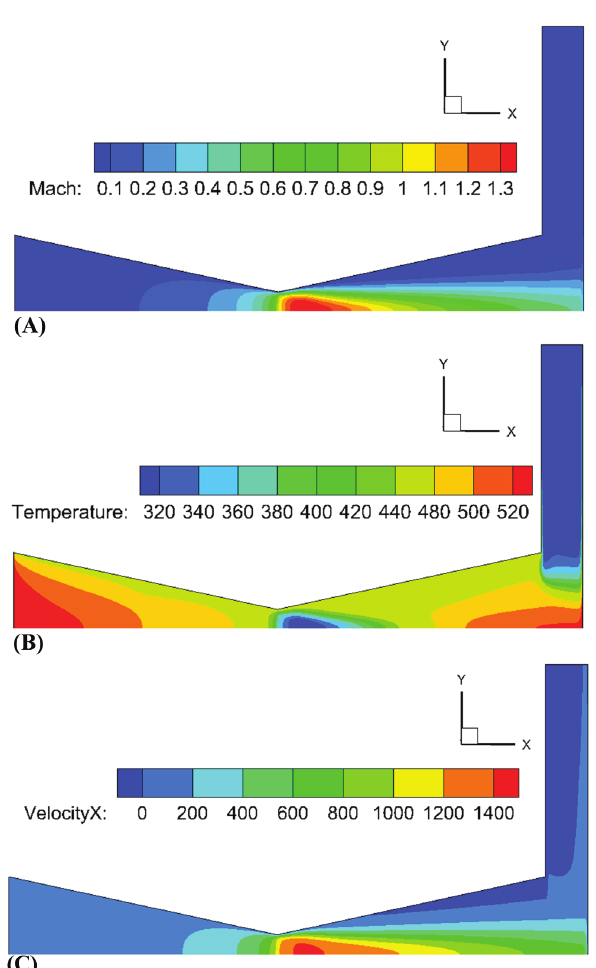
Figure 2. Contour plots of gas flow inside the nozzle and plenum depicting (A) Mach number; (B) Temperature; (C) Axial velocity